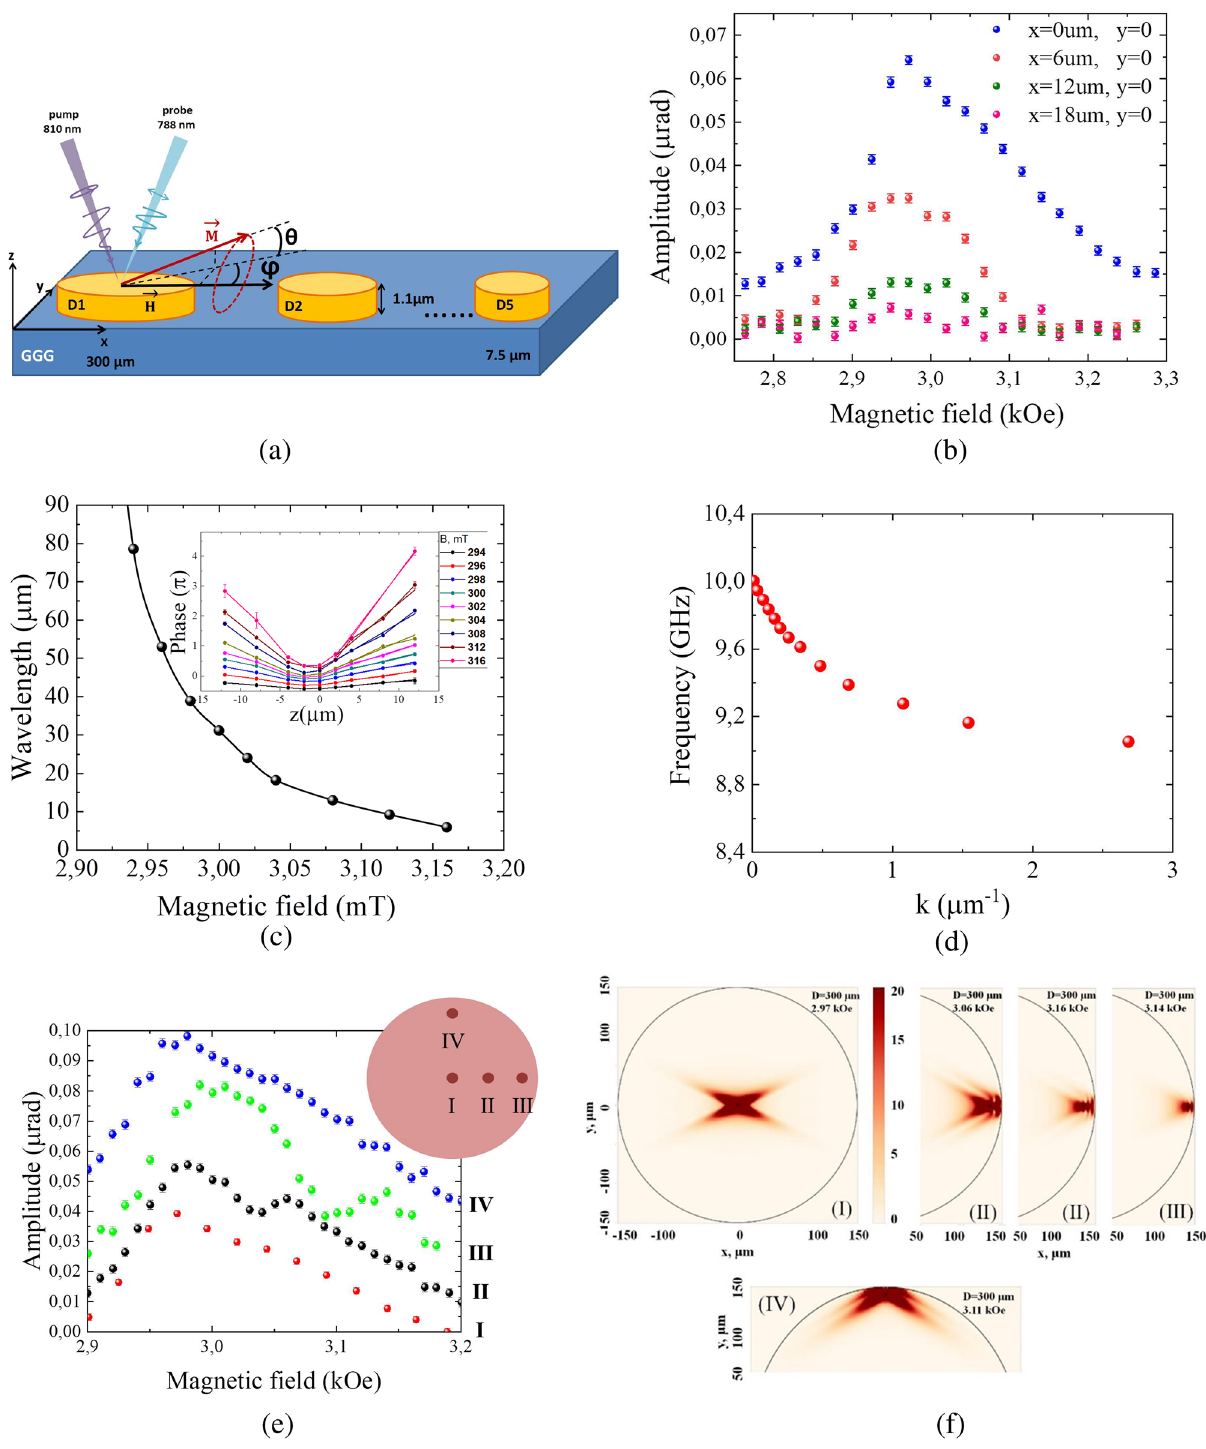
Figure 1. Experimental configuration ( a ) and the spin waves excited in the 300 µm disk ( b - e ). (Fig. 1(a) was drawn using power point software) ( b ) Dependence of the spin wave amplitude on the external magnetic field for different positions of the probe beam relative to the pump one. The pump beam is located in the center of the disk ( c ) Dependence of the spin waves wavelength on the external magnetic field derived from the behavior of the spin wave phase along the x-axis (see inset) measured for different magnetic fields. ( d ) Experimentally evaluated spin wave dispersion corresponding to backward volume magnetostatic spin waves (BVMSW). ( e ) Dependence of the spin waves amplitude on the applied magnetic field at four different positions of the pump and probe beams. ( f ) Simulated distribution of spin wave amplitude at four points indicated in ( e ). The inset shows these four positions on the microdisk. The pump fluence is 5.2 µJ/cm 2